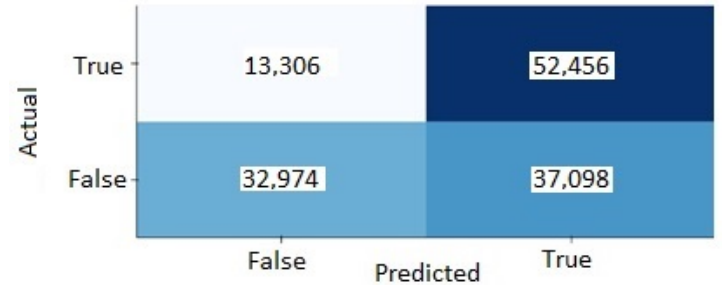
Figure 6. Confusion matrix of the second model.